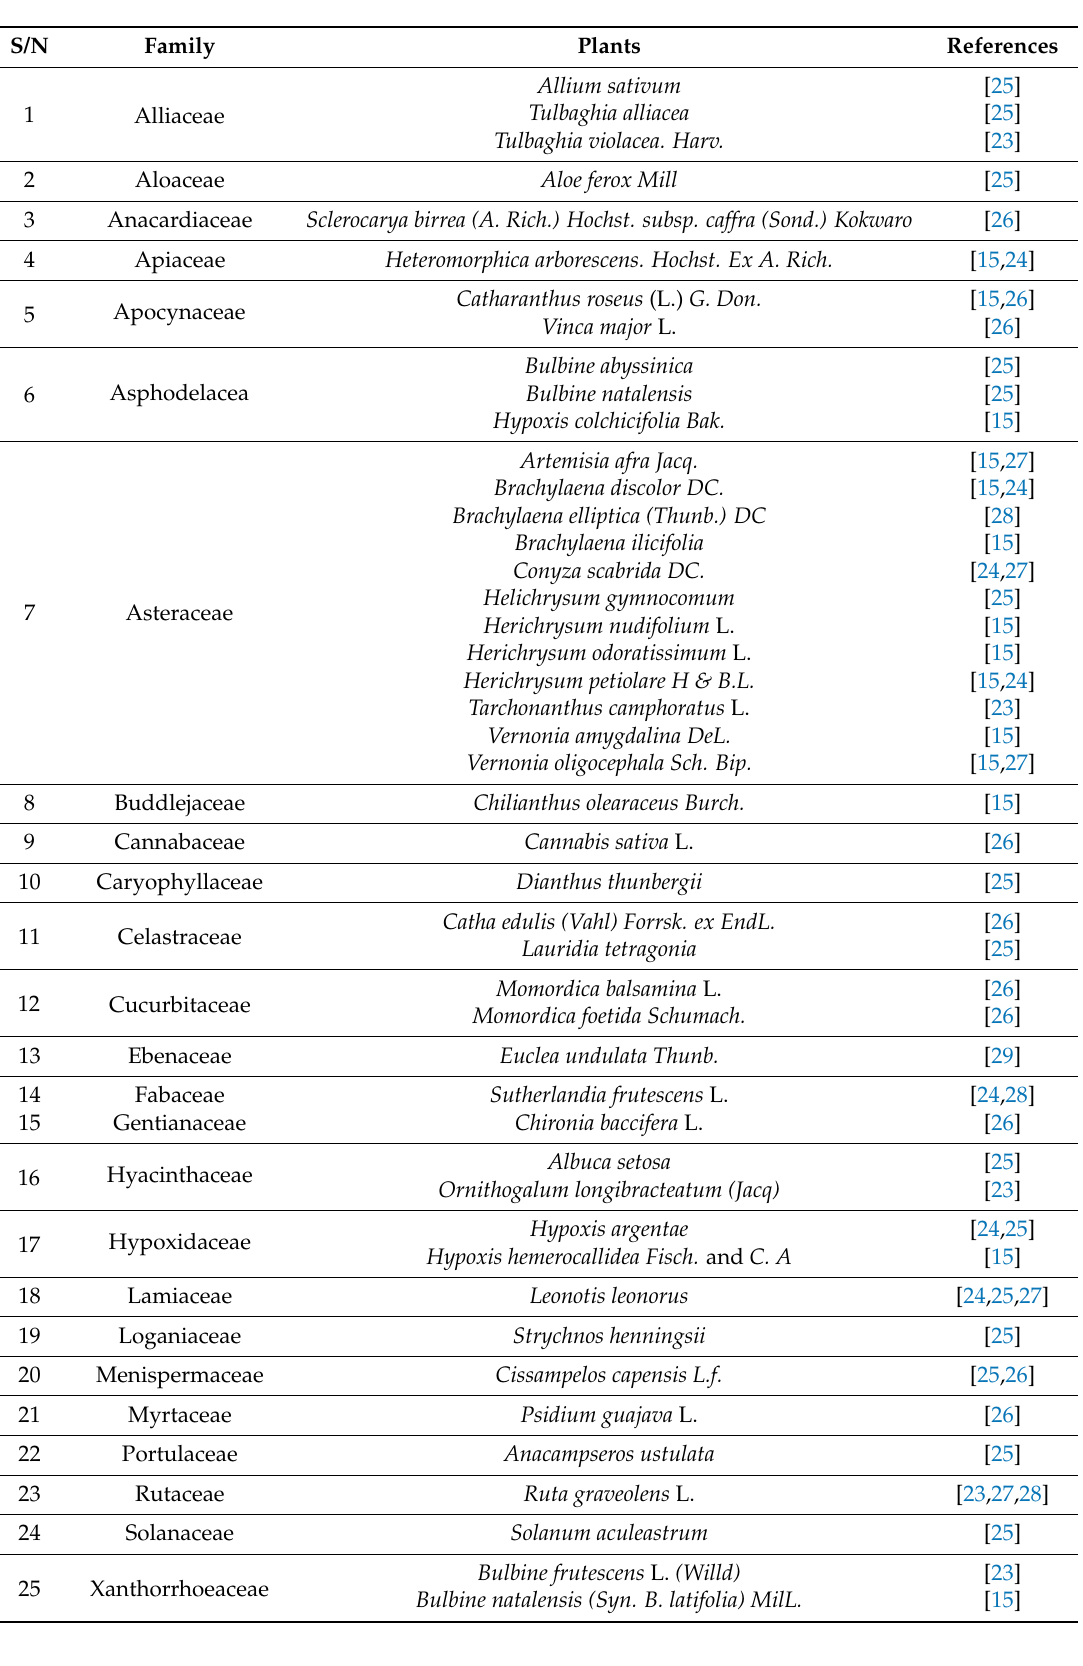
Table 1. Ethnobotanical information of plants used by traditional healers in Eastern Cape, South Africa. S/N: Serial